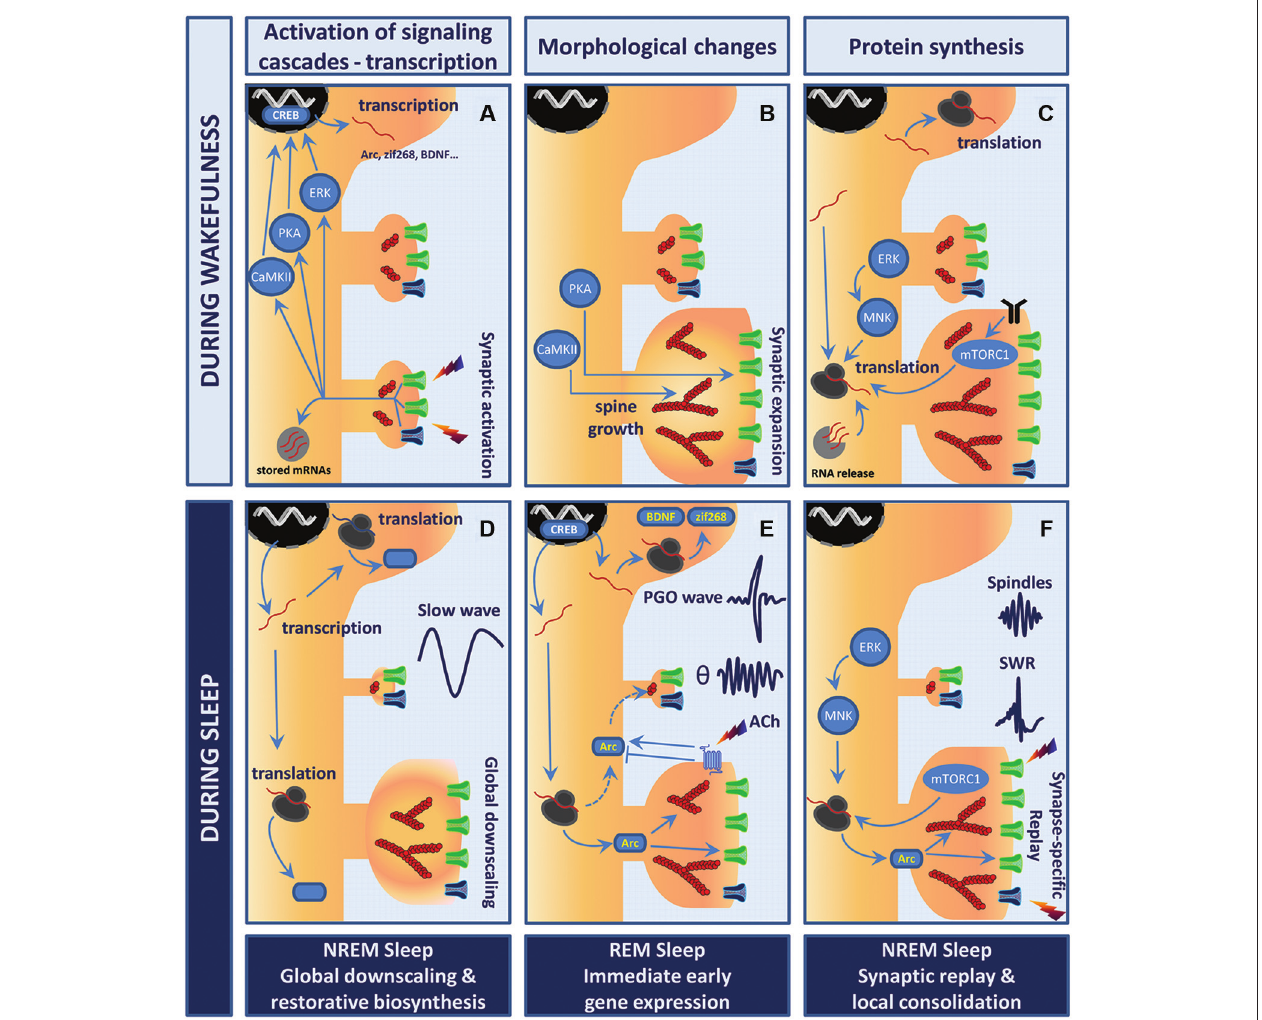
are TrkB (black), AMPAR (green) and NMDAR (blue). Sleep (D–F) . (D) NREM sleep supports the homeostatic process of cellular restoration by transcription and translation of genes involved in macromolecular biosynthesis and transport. In parallel, slow-wave activity (SWA) generates global synaptic downscaling in which synapses shrink and synaptic efficacy is reduced. Synapse-specific LTD at inactive or weakly active synapses may also be involved. (E) REM sleep and ponto-geniculo-occipital (PGO)-waves reactivate transcription of the plasticity-related IEGs Arc, brain-derived neurotrophic factor (BDNF) and zif268. Theta ( θ ) activity and increased acetylcholine levels regulate Arc protein turnover at the level of translation, degradation and mRNA decay. Arc may consolidate activity-induced synaptic changes by stabilizing the actin cytoskeleton and regulating trafficking of AMPAR from and to the postsynaptic membrane. (F) NREM sleep events like hippocampal sharp wave-ripples (SWRs) and thalamo-cortical sleep spindles have been suggested to actively take part in memory consolidation in conjunction with replay of neuronal activity patterns representing waking experience. The precise function of SWRs at the synaptic scale is yet to be unveiled. However, sparse and synapse-specific reactivations during SWRs of NREM sleep could provide bursts of local protein synthesis that consolidate synaptic modifications and memory formation. Thus, alternations of REM sleep-associated gene expression and NREM sleep-associated synaptic replay favor protein synthesis-dependent synaptic consolidation across sleep